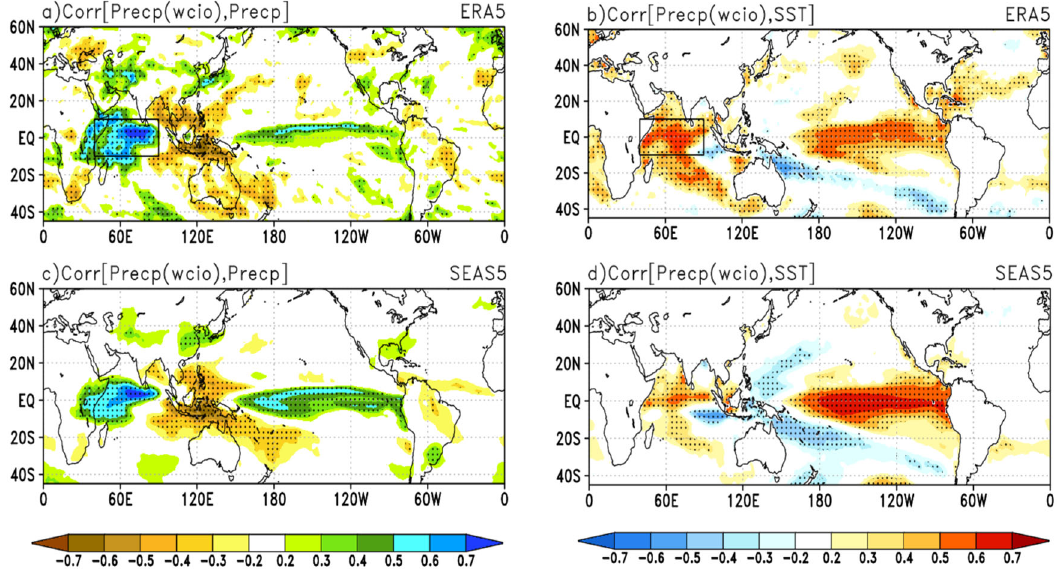
Fig. 1 Western-Central Indian Ocean (WCIO) precipitation anomalies relationship with precipitation and SSTs. a Correlation of the western-central Indian Ocean (WCIO) precipitation anomalies with the global Precipitation during early winter (November-December; ND); ( b ) same as of ( a ) but with the global Sea Surface Temperature (SST) anomalies; ( c , d ). same as of ( a , b ) but for the ECMWF-SEAS5 dataset. Stippling denotes statistical signi fi cance at 95% con fi dence